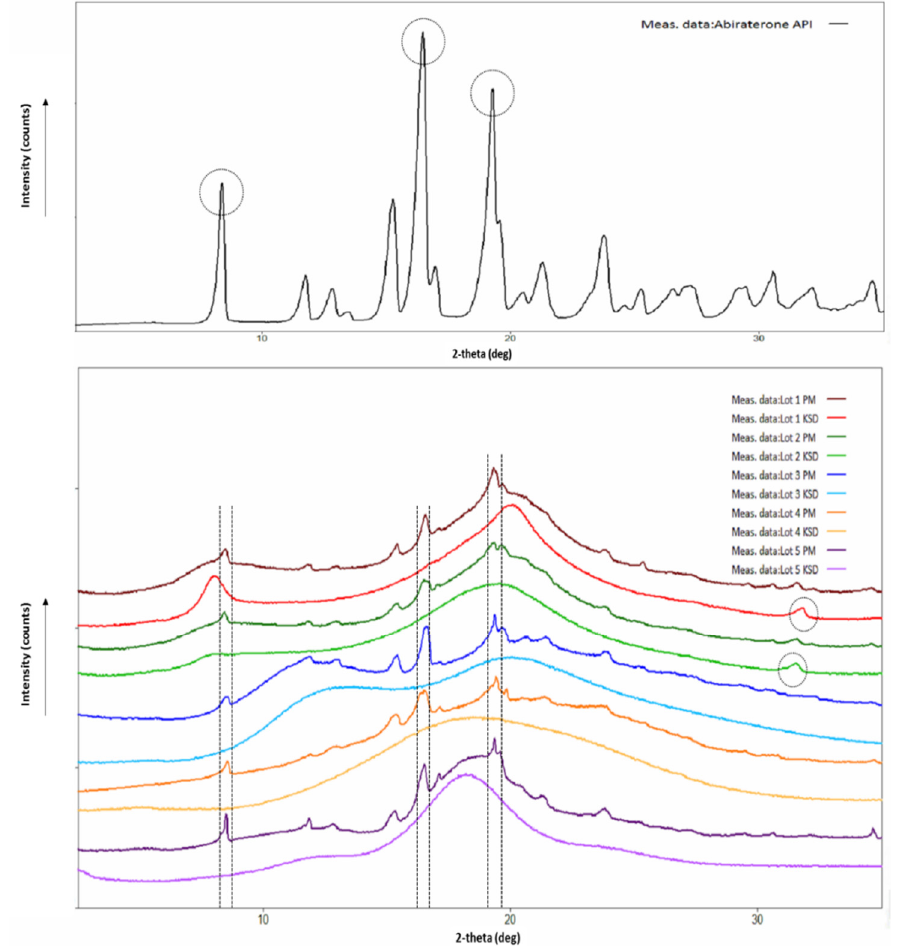
Figure 3. X-Ray diffractograms of abiraterone API (top) and abiraterone binary PMs, KSDs (bottom). Figure 3. X-Ray di ff ractograms of abiraterone API (top) and abiraterone binary PMs, KSDs